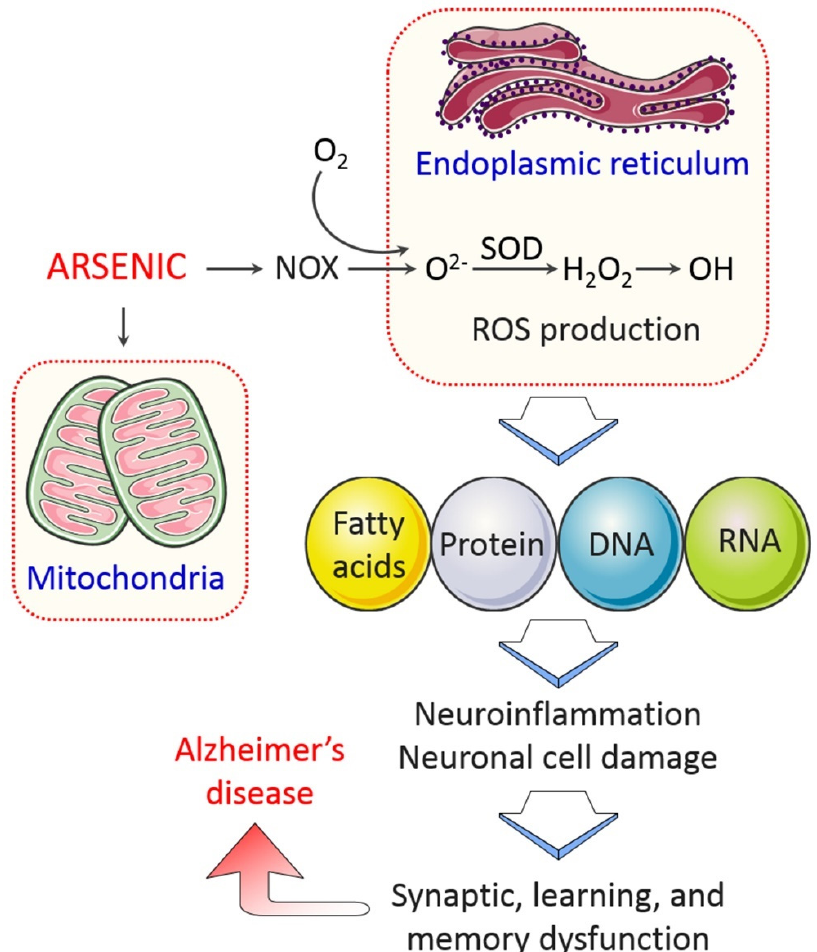
Figure 2. Arsenic-induced mitochondrial dysfunction and ROS generation in AD. As induces ROS production by mitochondrial dysfunction. NADPH oxidase (NOX) contributes to generate superoxide anions, which leads to the release of ROS in cells. ROS generation impairs fatty acids, proteins, and DNA, inducing neuroinflammation and subsequently causing cognitive dysfunction in AD.